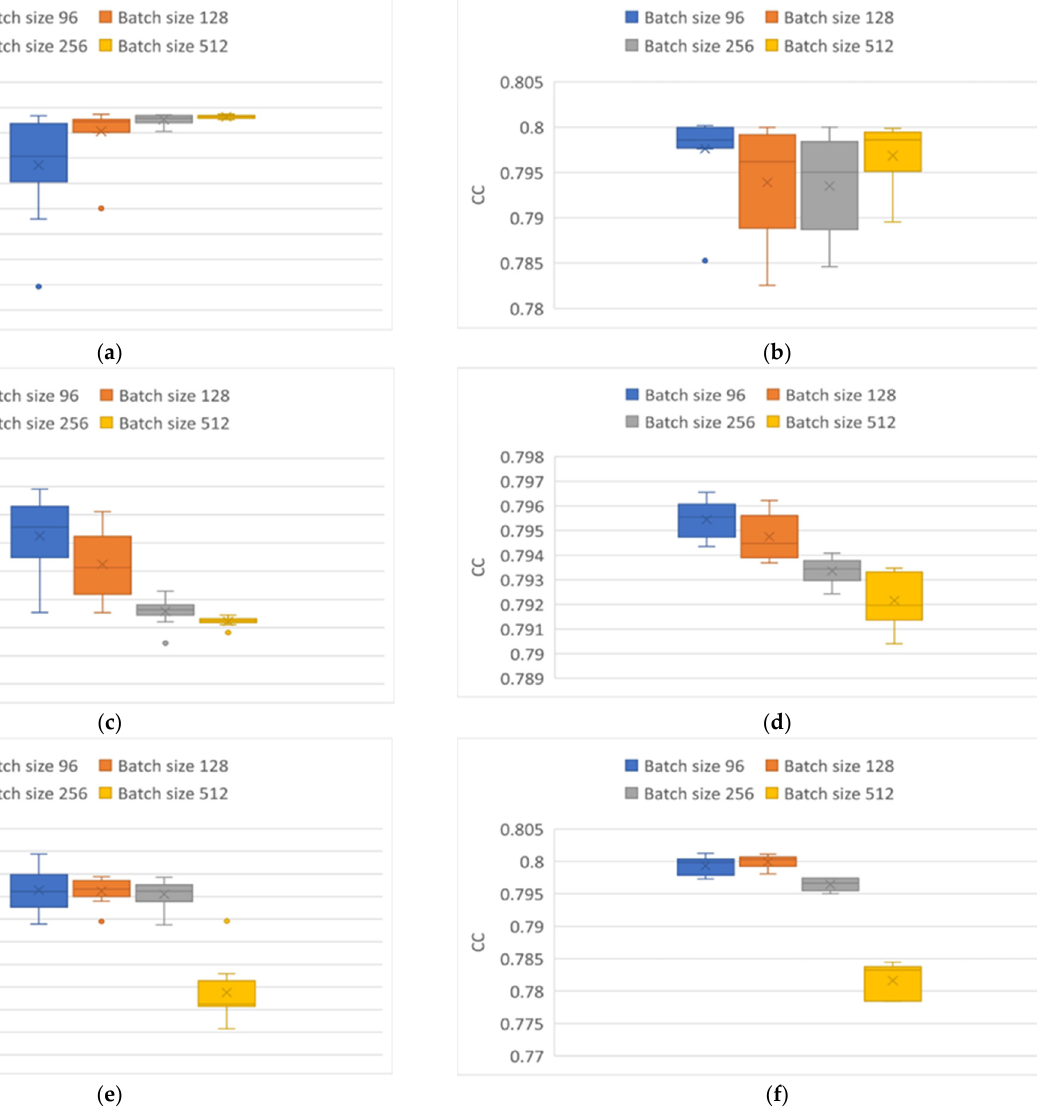
Figure 9. CC variability in PM 10 particle behavior modeling. ( a ) Elman neural network using Adam optimizer. ( b ) Elman neural network using Adamax optimizer. ( c ) GRU neural network using Adam optimizer. ( d ) GRU neural network using Adamax optimizer. ( e ) LSTM neural network using Adam optimizer. ( f ) LSTM neural network using Adamax optimizer.